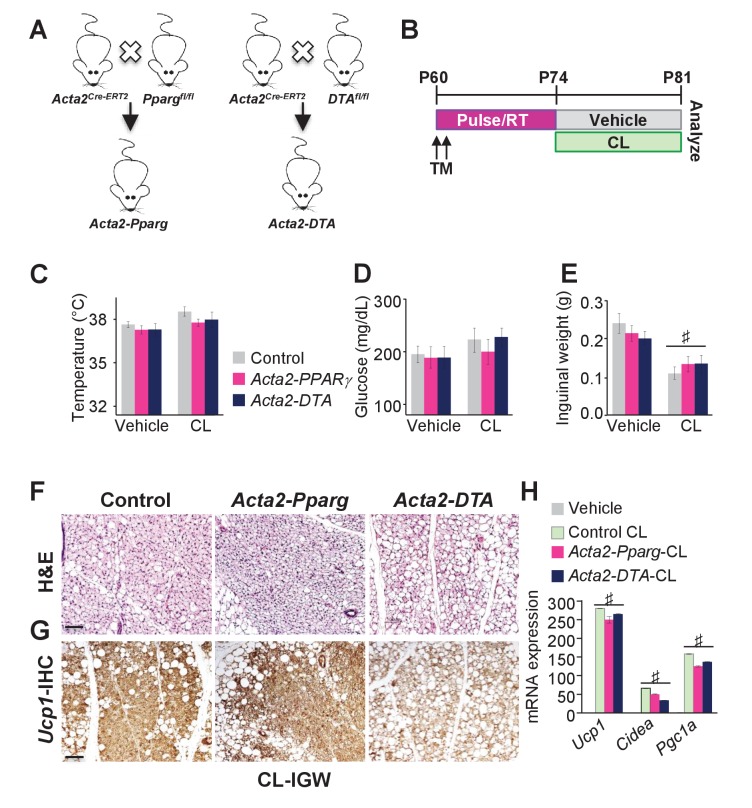
Acta2 Adrb3 necessity tests.(A) Genetic schema to generate two-month-old Acta2Cre-ERT2; Ppargfl/fl or DTA male mice. (B) Experimental procedure for mice described in (A) (n = 10/group). (C) Rectal temperature from mice in (A). (D) Sera glucose from mice in (A). (E) Inguinal adipose tissue (IGW) weights from mice in (A). (F) Representative H&E staining of IGW depot sections from mice described in (A). Scale bar = 100 µm. (G) Representative Ucp1 IHC staining of IGW depot sections from mice described in (A). Scale bar = 100 µm. (H) mRNA expression of beige and thermogenic gene expression from mice described in (A) (n= 6 in triplicate). ♯p<0.001 unpaired t-test, two tailed: CL compared to vehicle-treated mice (control and mutant). All data are means ±SEM.